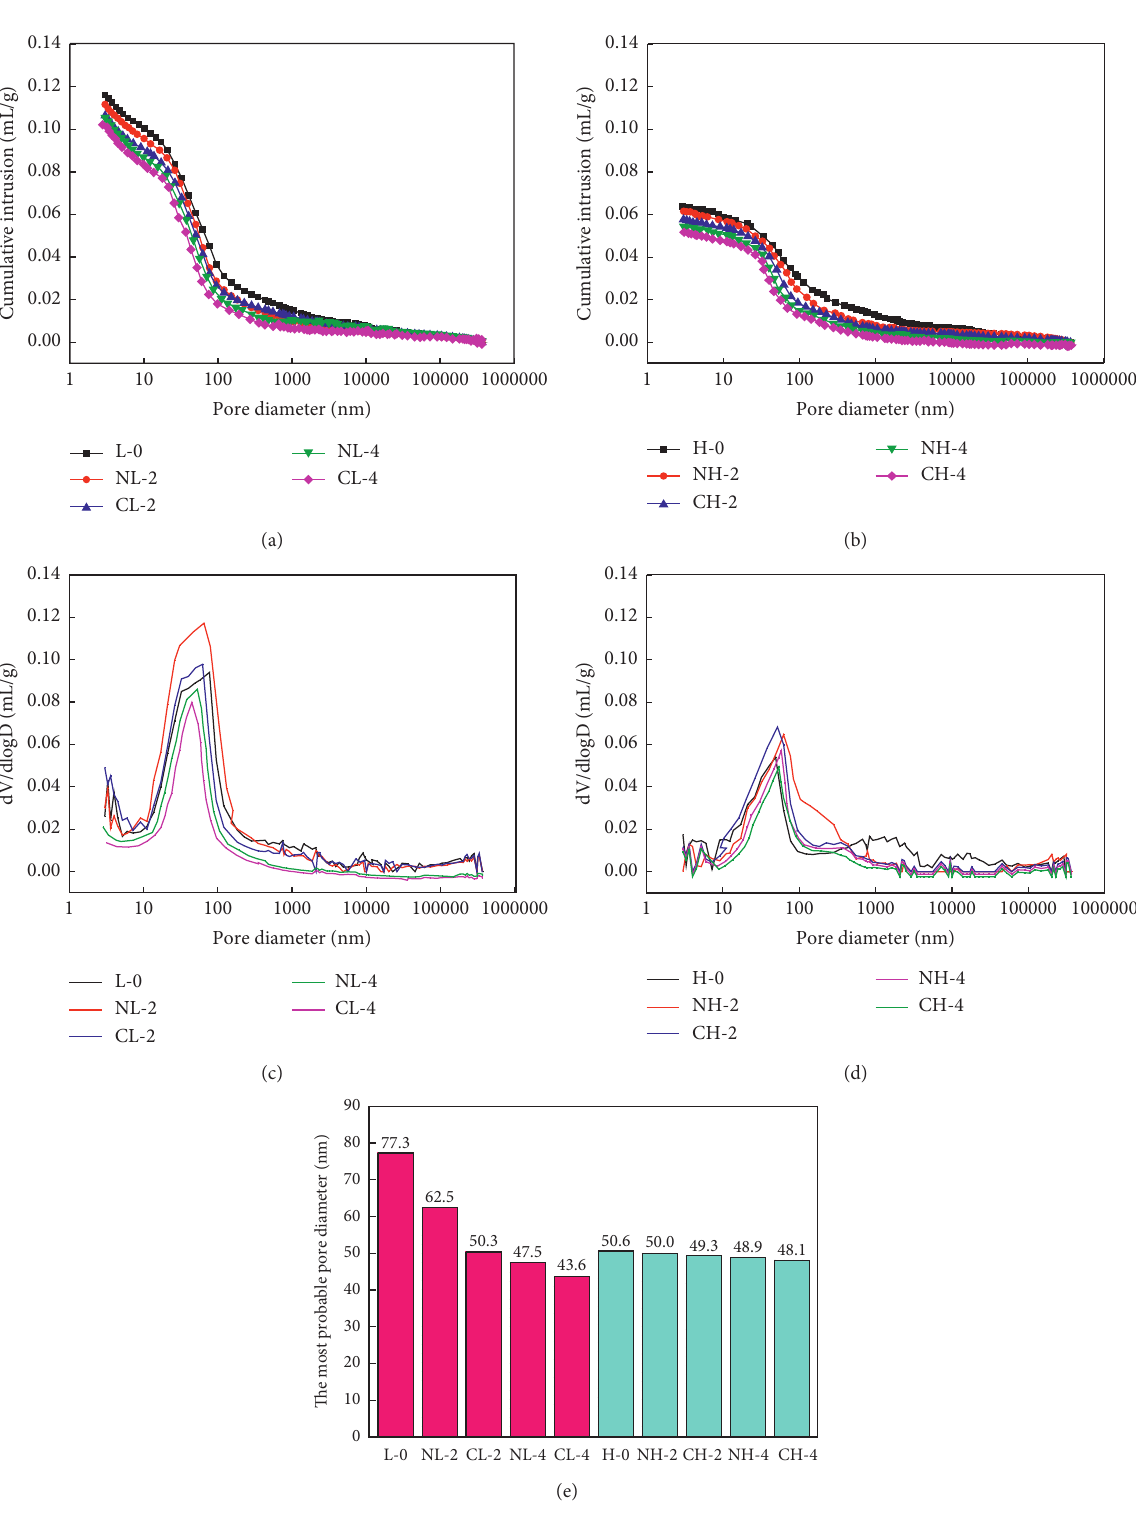
Figure 7: Pore size distribution of concrete. Cumulative distribution of pore size of (a) C30 and (b) C50. Differential distribution of pore size of (c) C30 and (d) C50. (e) The most probable pore size of